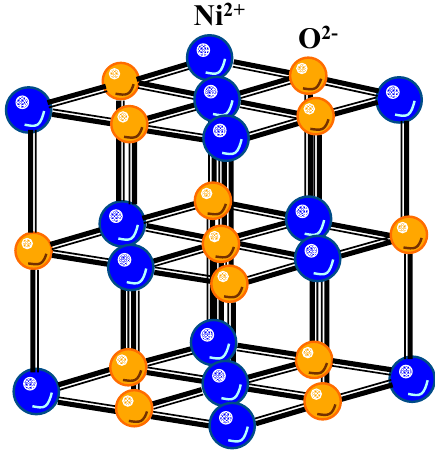
Figure 1. Crystal structure of the NiO thin film.